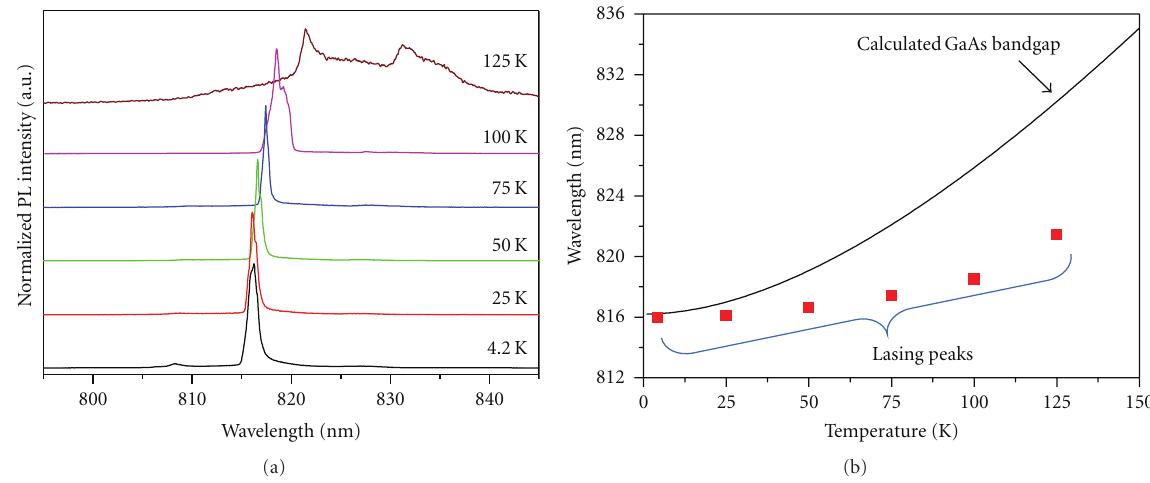
Figure 27: Normalized temperature-dependent spectral features recorded from single GaAs/GaAsP nanowire for lasing. (a) PL spectra for lasing recorded at 4.2, 25, 50, 75, 100, and 125K. (b) Plots of temperature-dependent lasing wavelengths (marks with filled squares). Dependence of temperature on GaAs bandgap is also given in curve for comparison